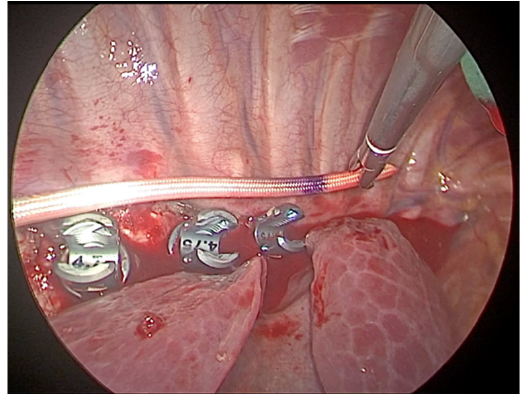
Figure 8. After all vertebral bodies are instrumented, the tether is inserted through the most caudal incision and placed in the tulips of the screws starting from the two most cephalic positions.